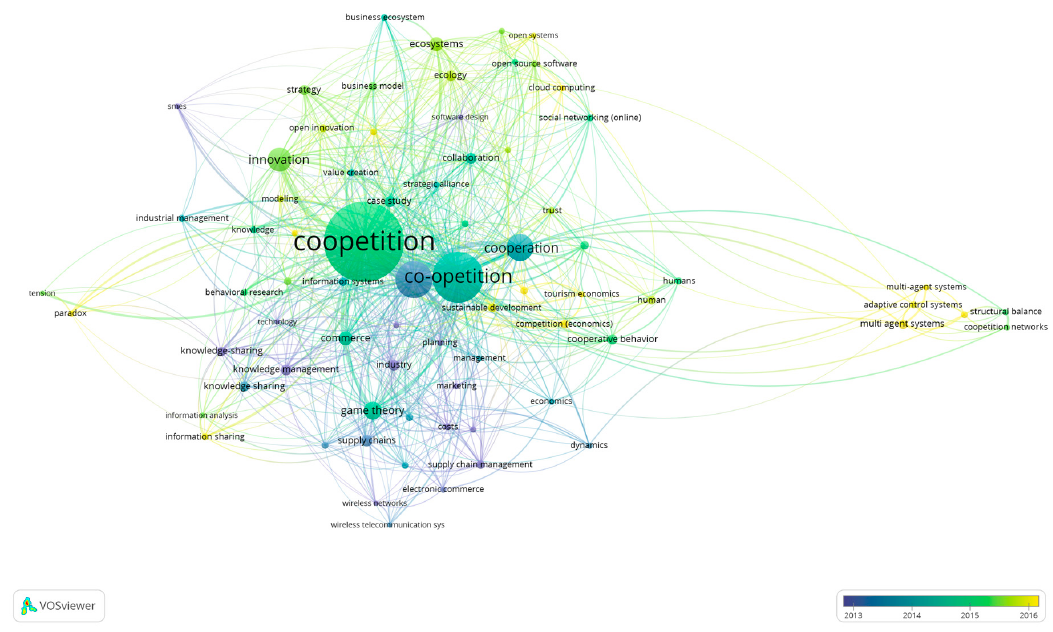
Figure 6. Overlay visualization of most frequent terms (Constructed via VOSViewer v.1.6.10 for the sample N = 664, f (frequency) > 6), where the score of the item is time since publication.